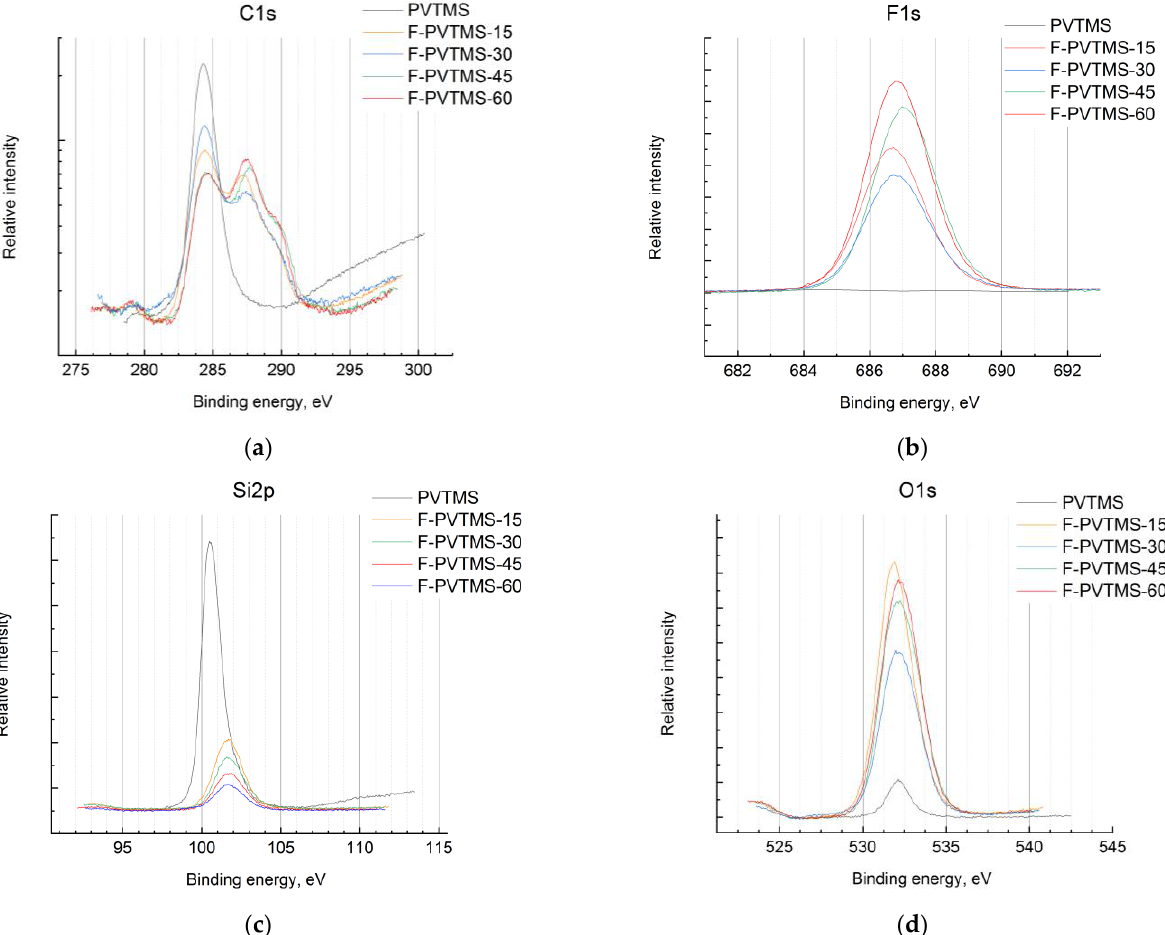
Figure 7. XPS spectra of C1s ( a ), F ( b ), Si2p ( c ), and O1s ( d ) lines for the control sample (PVTMS) and PVTMS films fluorinated for 15 (F-PVTMS-15), 30 (F-PVTMS-30), 45 (F-PVTMS-45), and 60 min (F-PVTMS-60).